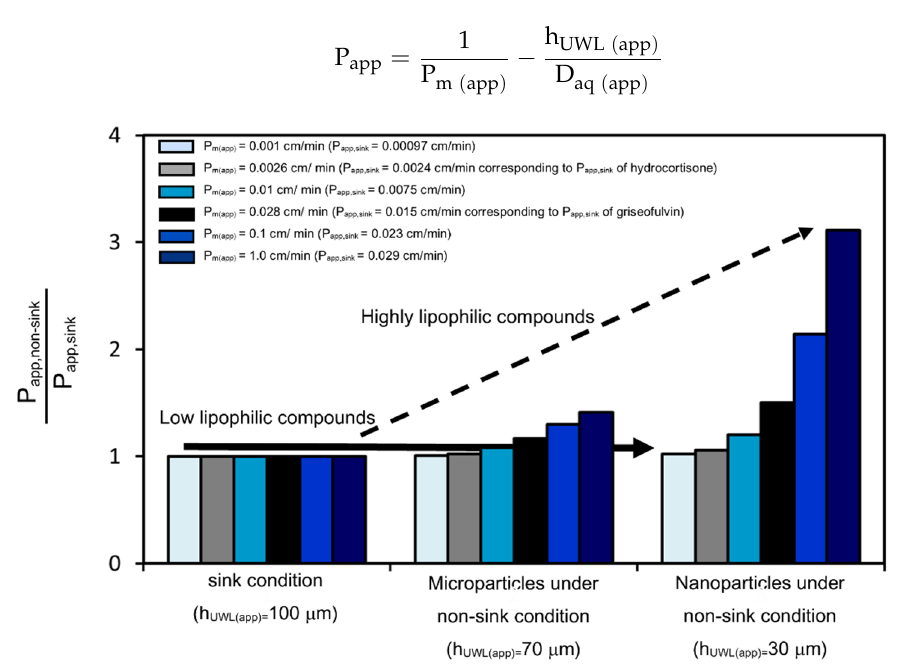
Figure 11. Calculated permeability improvement effect for microparticle and nanoparticle com- pounds under non-sink conditions. The permeability of model compounds ranges from P app,sink = 0.00097 cm/min to P app,sink = 0.029 cm/min. P app,sink and P app,non-sink represent the P app under sink condi- tions and under non-sink conditions,